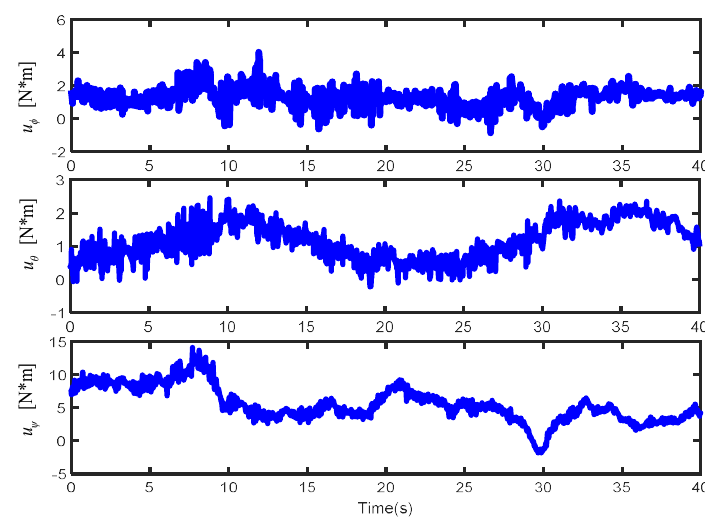
Figure 11. Filtering operations upon angular rates.